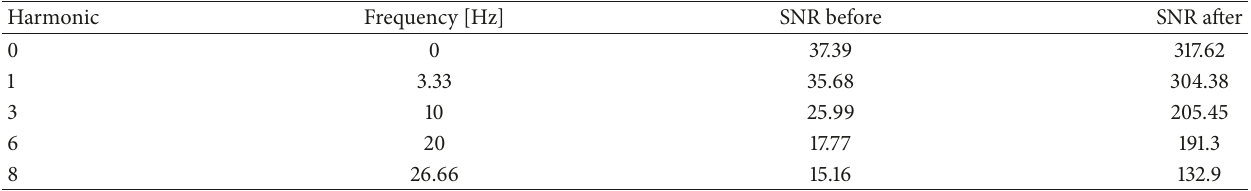
Table 3: SNR comparison.